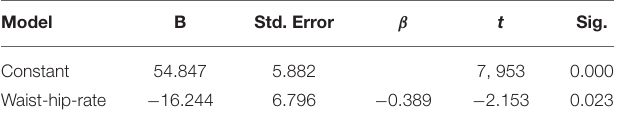
TABLE 4 | Regression estimation